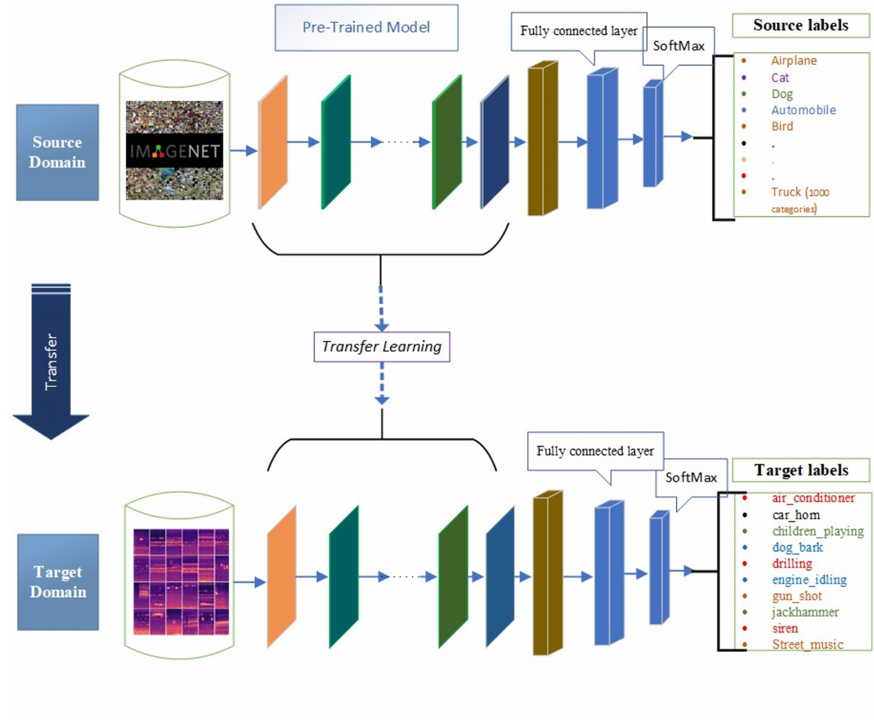
Figure 1. Illustration of transfer-learning workflow for environmental sound